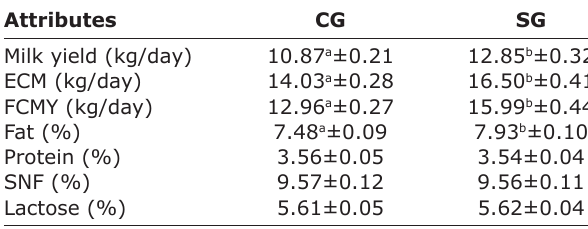
Table-6: Mean milk yield and composition changes in control and prilled fat supplemented buffaloes.